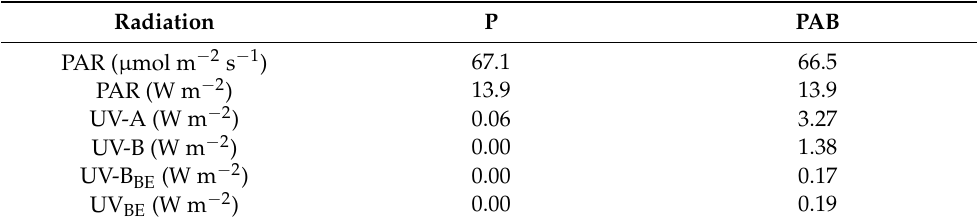
Table 3. Radiation conditions in the two radiation regimes used: P (only photosynthetically active radiation, PAR) and PAB (PAR + UV-A + UV-B). Biologically effective UV-B radiation (UV-B BE ) and biologically effective UV radiation (UV BE ) were calculated using the action spectra by Caldwell [61] and Flint and Caldwell [62],